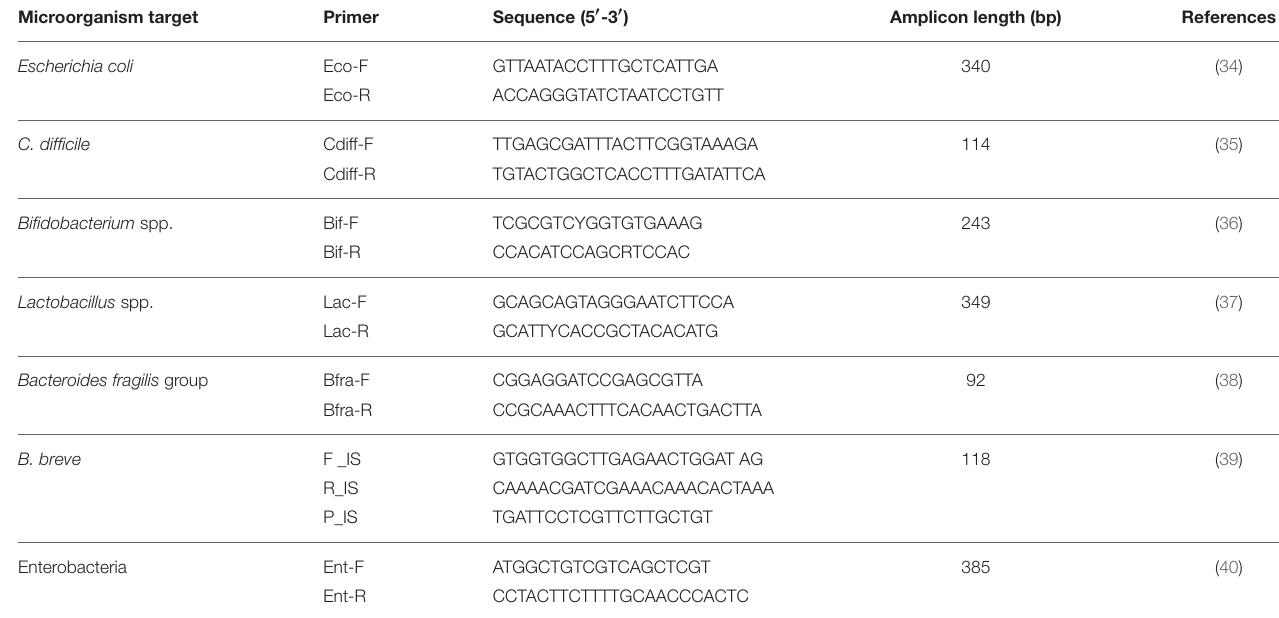
TABLE 1 | Primer sequences and qPCR conditions used in the different